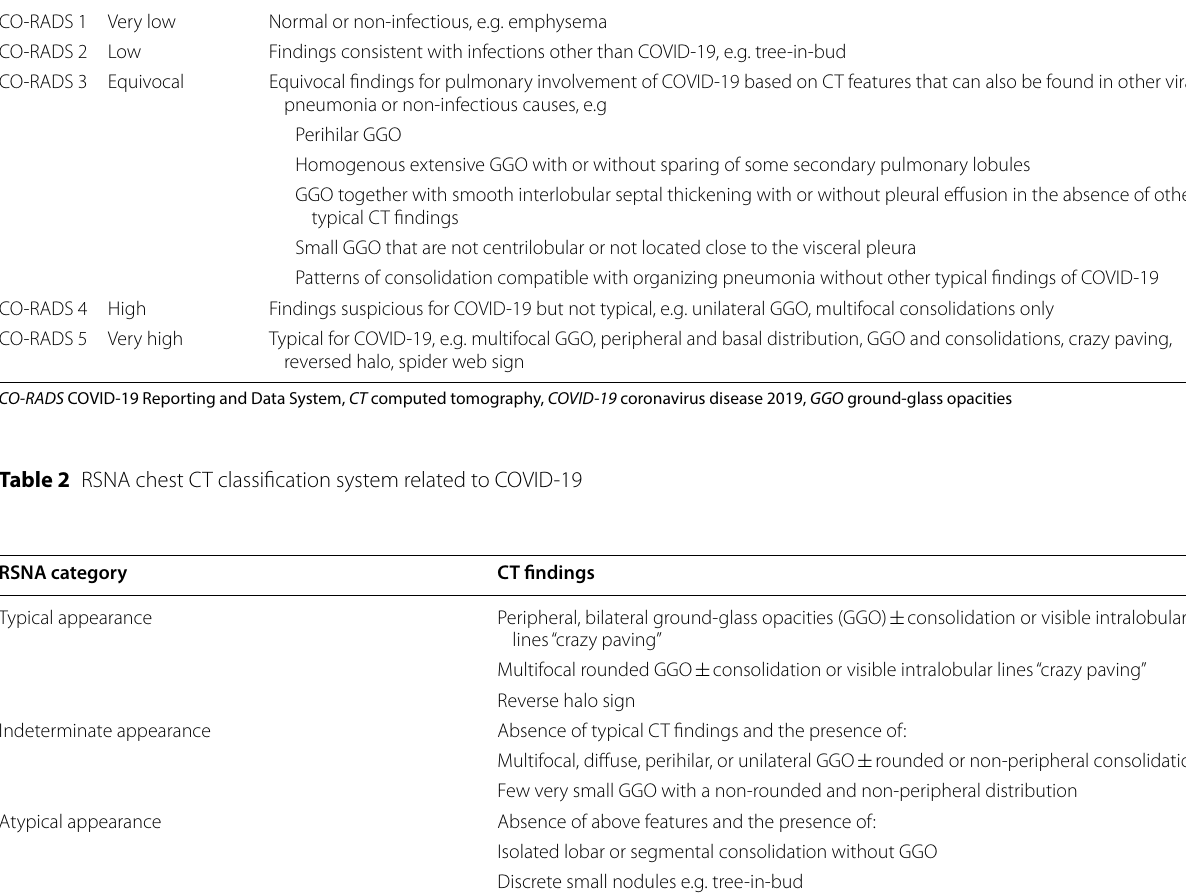
Table 1 CO‑RADS categories